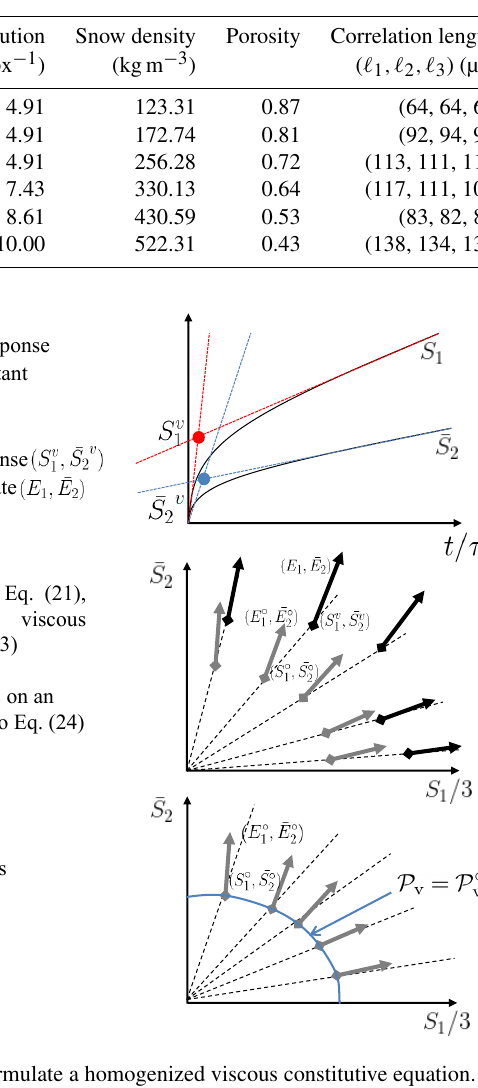
Table 2. Names and principal characteristics of the six snow images of Wautier et al. (2015) used in this study.